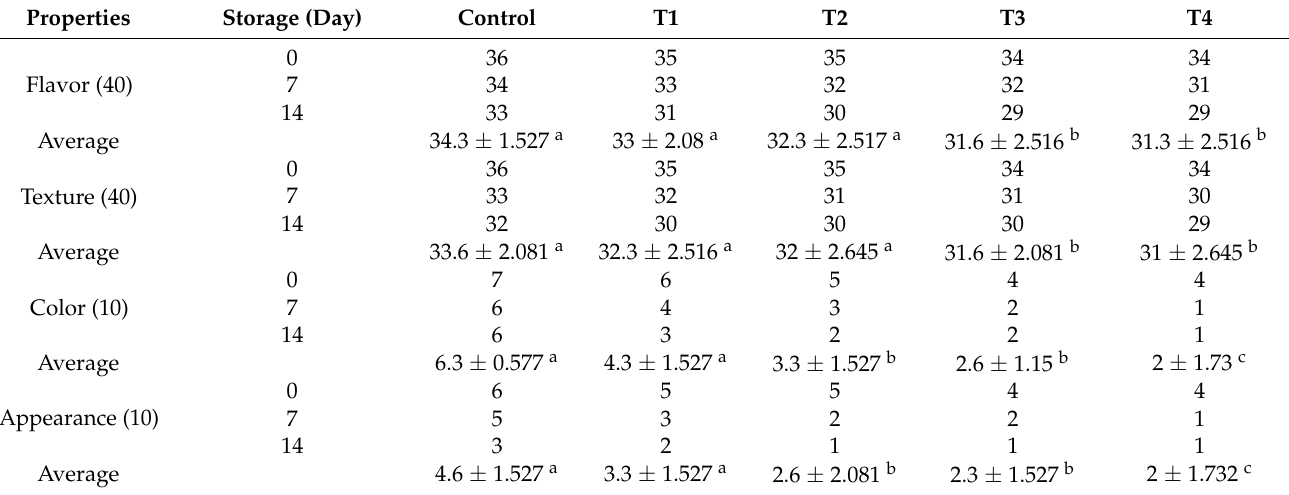
Table 4. Sensory evaluation of symbiotic yoghurt fermented